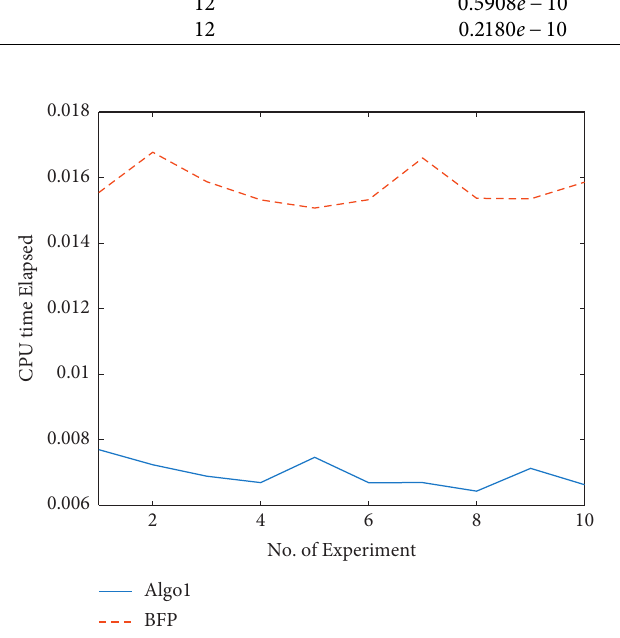
Figure 1: CPU time graph and iteration vs error graph.